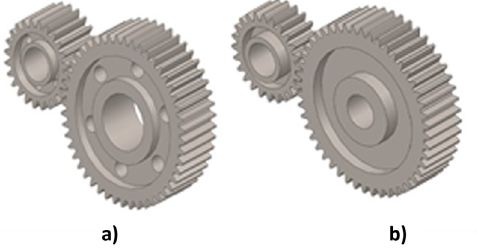
Fig. 2. (a) Hub-hole pro fi le, (b) Hub pro fi le.